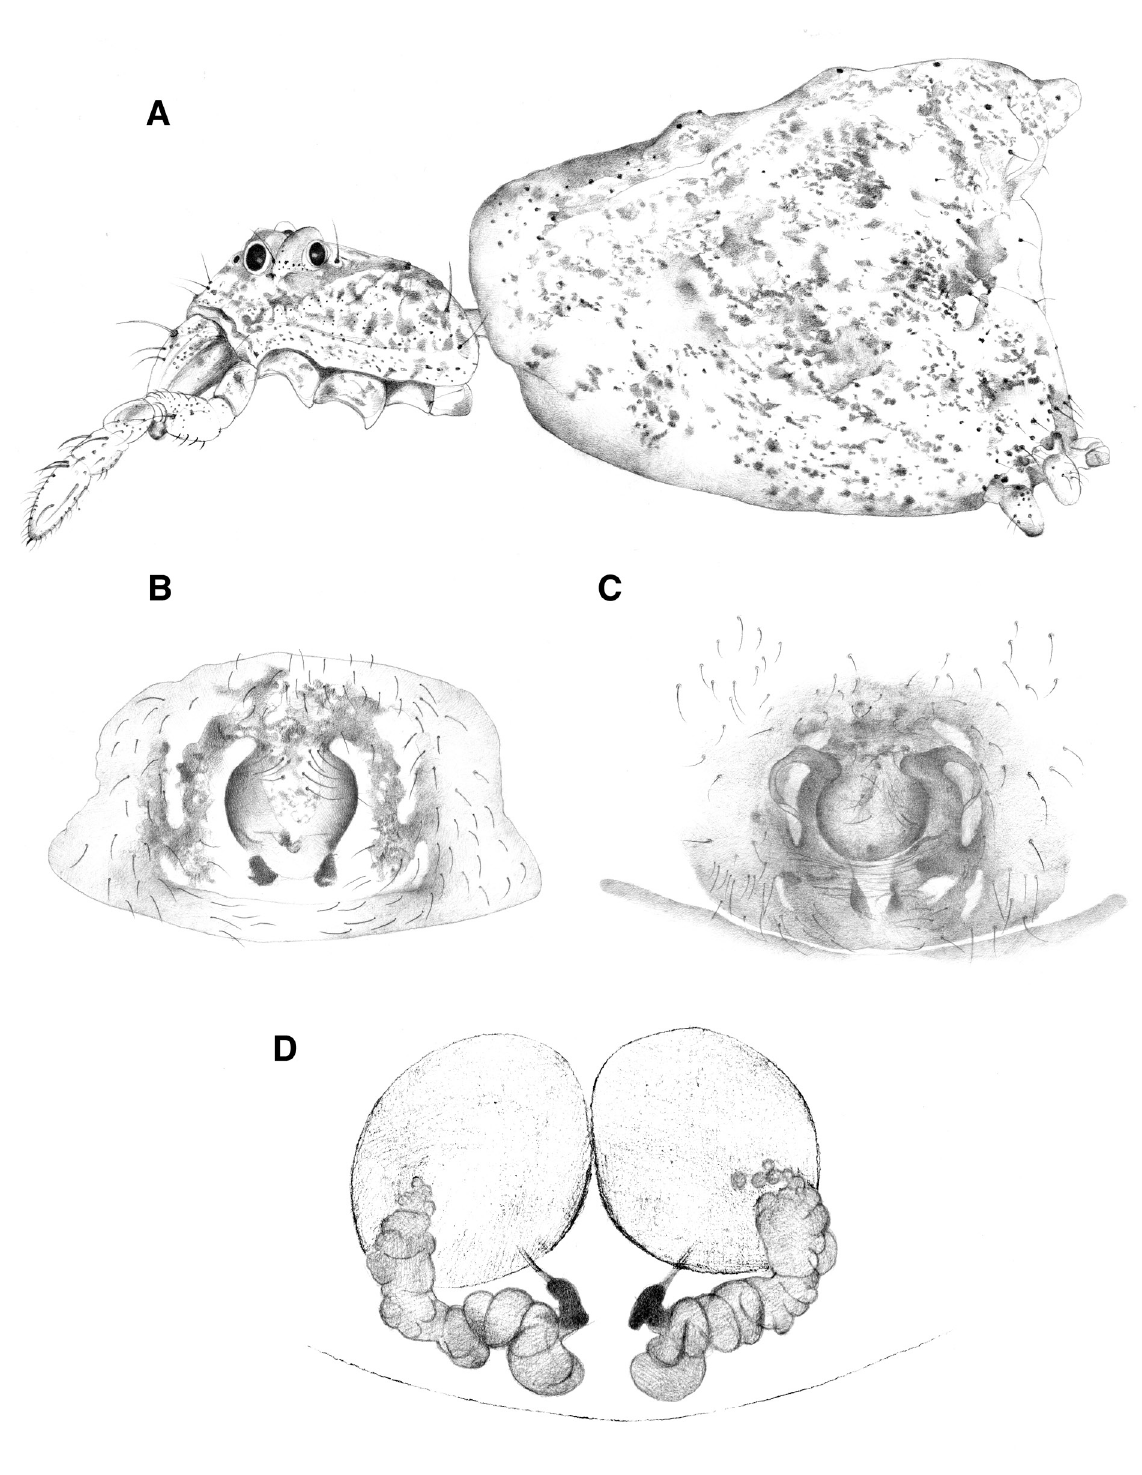
Fig. 5. Tmarus galapagosensis sp. nov., ♀. A . Lateral view. B-C . Epigyne. D .